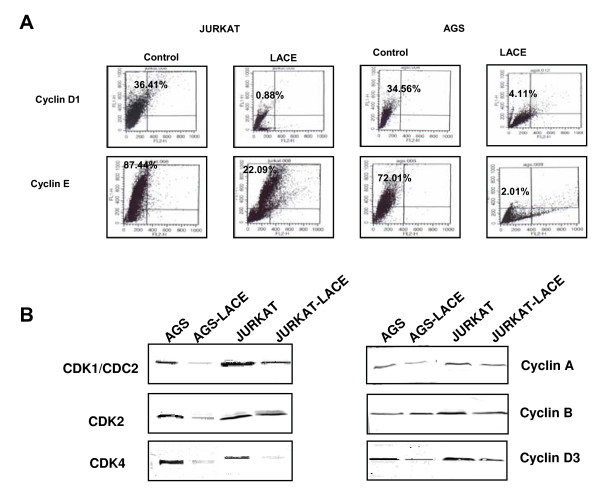
Effect of LACE on cyclins and CDKs. The cell lines AGS and JURKAT were cultured in alone medium or treated with LACE. a) Flow cytometric analysis was performed for the expression of cyclins D1 and E. The LACE extract produced a strong inhibition of expression of both cyclins. b) The western blot analyses showed that LACE produced down-regulation of cyclins D3 y A and CDK1/Cdc2, CDK2, CDK4, CDK6. The cyclin B expression was not modified.